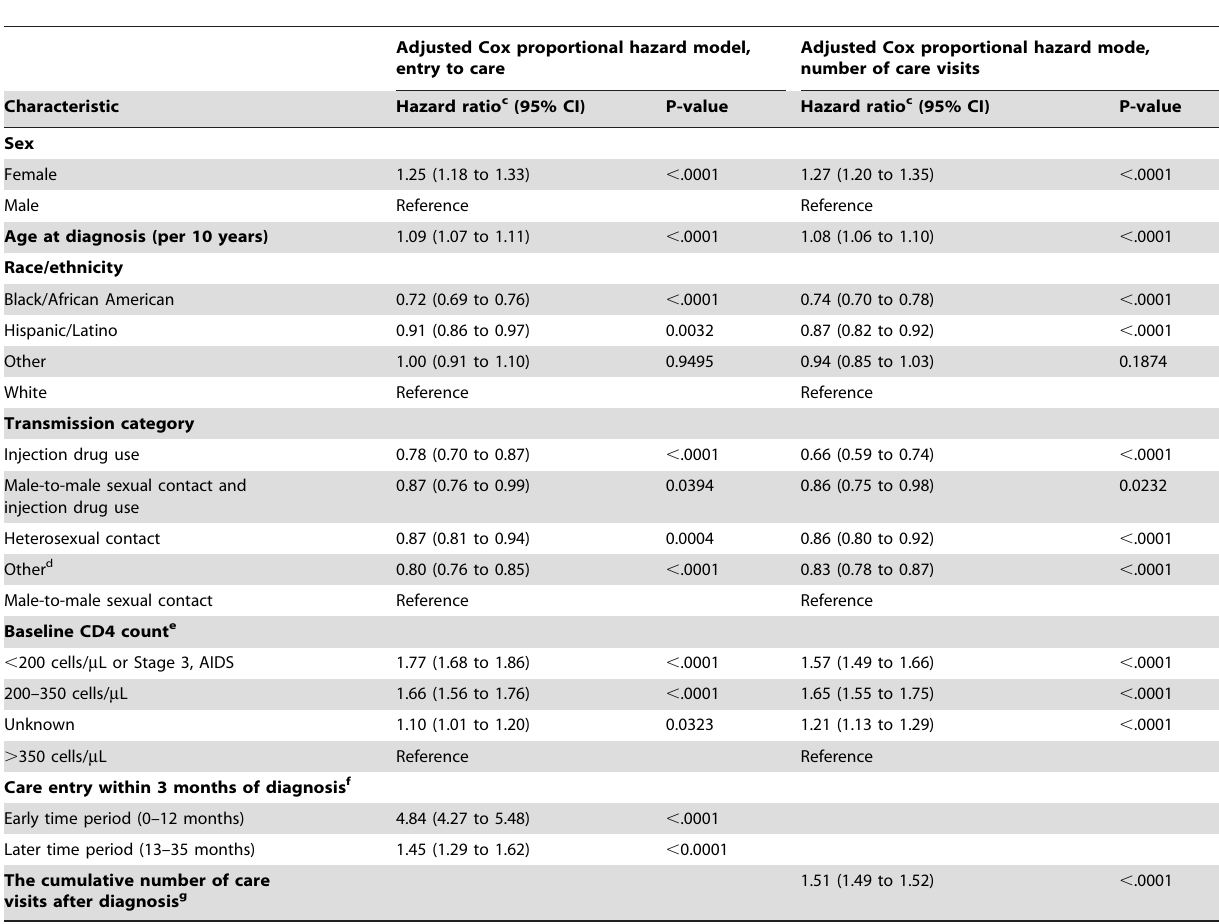
Table 2. Factors associated with viral suppression a among adolescents and adults diagnosed with HIV infection b , 2009, 19 U.S.